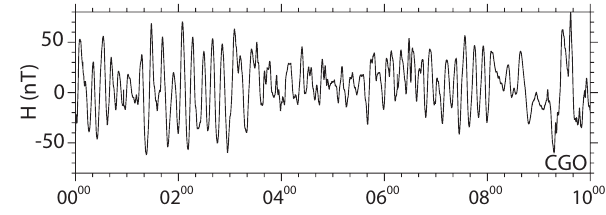
Fig. 6. The H-component ground magnetometer data from CGO for the interval 00:00–10:00 UT on the 25 November 2001.